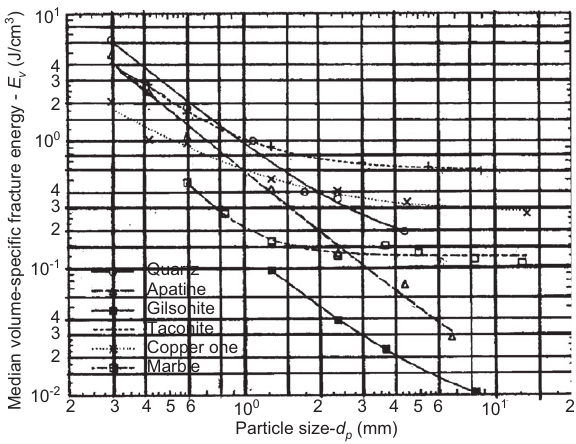
Figure 1 Specifi c energy-size relationship by Tavares and King [2]